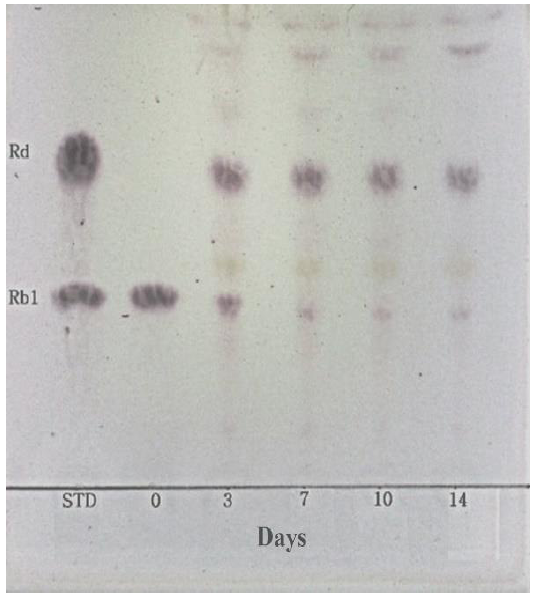
Figure 6. TLC analysis of ginsenoside Rb1 conversion by culture broth of Lentilactobacillus buchneri URN103L under the optimum condition for 14 days of hydrolysis. STD: standard.